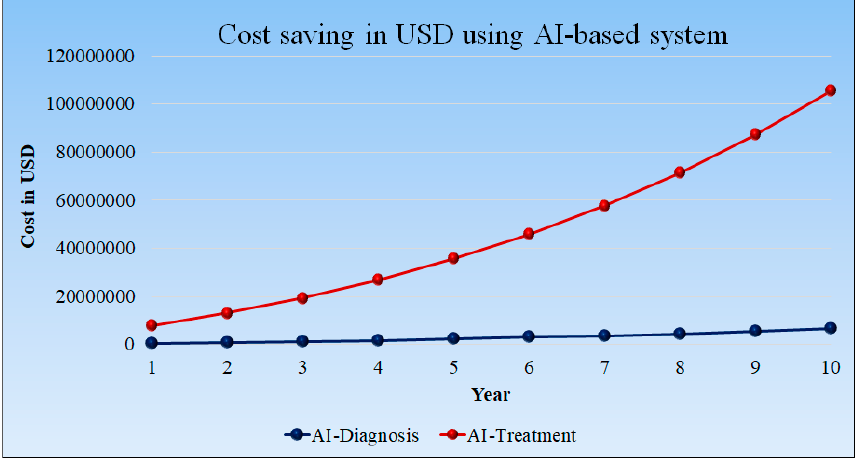
Figure 16. Cost saving in USD using AI ‐ based system, AI ‐ Diagnosis (blue), AI ‐ Treatment